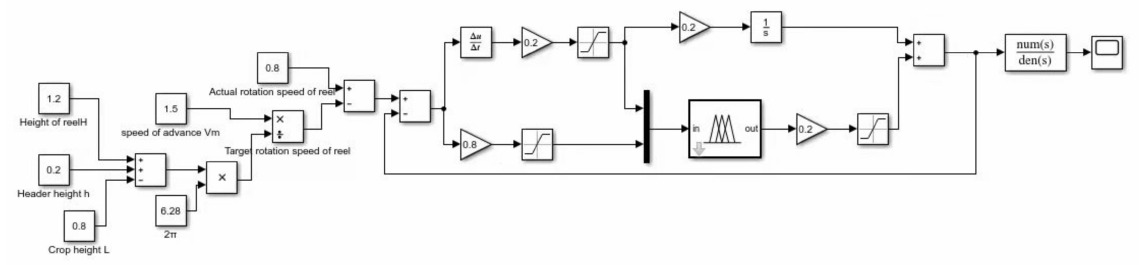
Figure 14. Simulation model.